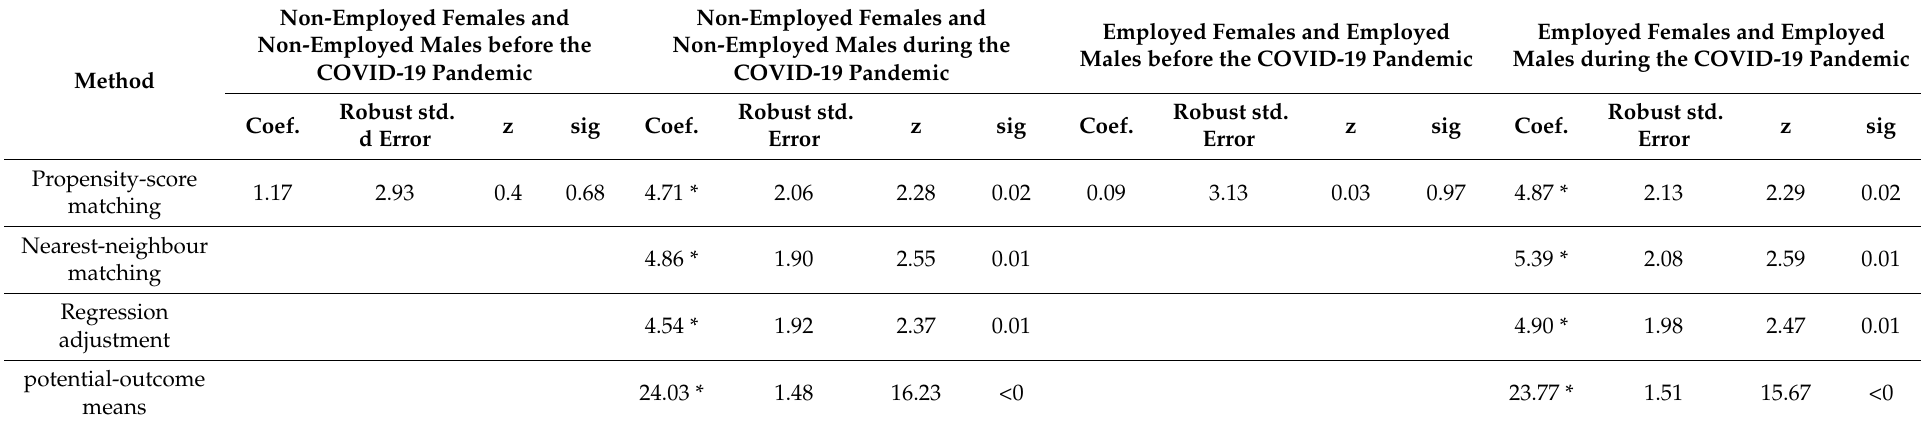
Table 4. Comparisons between females and males according to their status in labor market before and during the COVID-19 pandemic. Non-Employed Females and Non-Employed Females and Employed Females and Employed Employed Females and Employed Non-Employed Males before the Non-Employed Males during the Males before the COVID-19 Pandemic Males during the COVID-19 Pandemic COVID-19 Pandemic COVID-19 Pandemic Method Robust std. Robust std. Robust std. Robust std. Coef. z sig Coef. z sig Coef. z sig Coef. z d Error Error Error